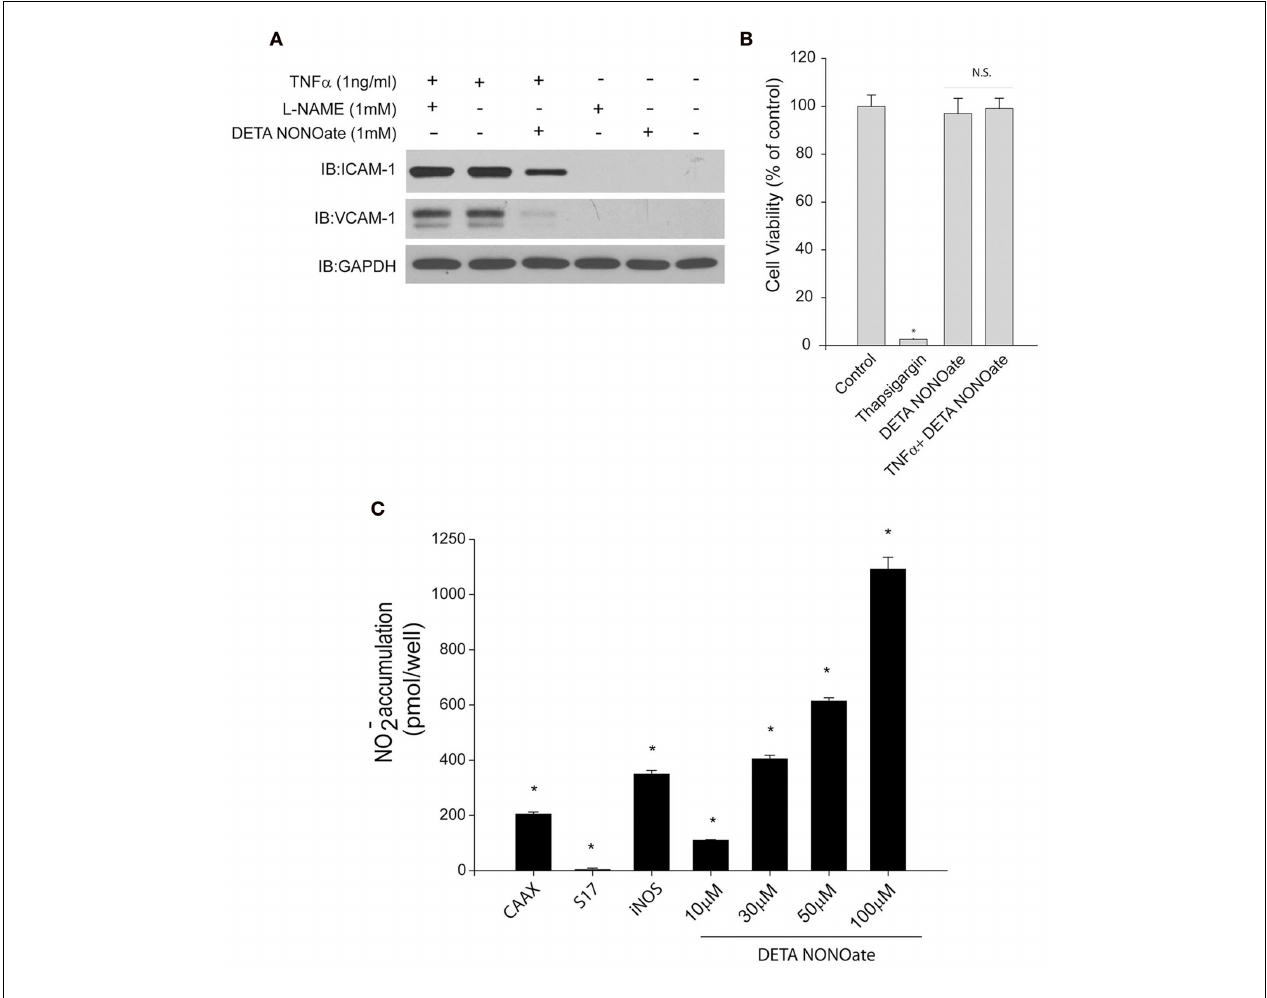
as above, cell viability was detected by MTT assay 24h after treatment. (C) Nitric oxide release from cells expressing RFP, S17-eNOS, CAAX–eNOS, or iNOS or from different concentrations (10, 30, 50, 100 μ M) of DETA NONOate over 24h. Results are presented as mean ± SEM ( n = 5). ∗ p < 0.05 versus control